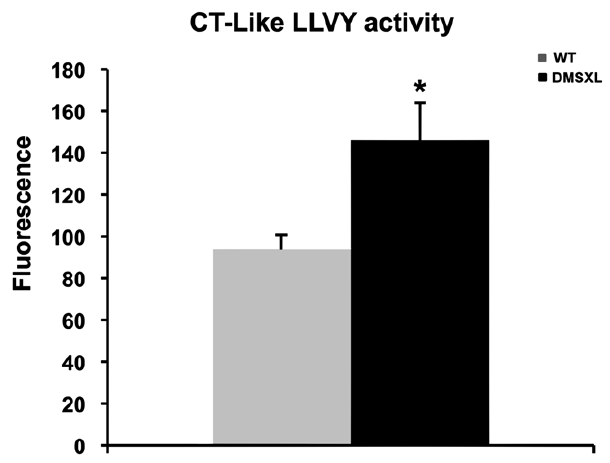
Figure 10. Proteasome activity in DMSXL mice. Chymotrypsin-like activities of the proteasome were assayed using the fluorogenic peptides LLVY-AMC in 4-month-old female WT and DMSXL mice. Each group contained ten animals and each animal was assayed in triplicate. Histogram bars represent the average activity 6 SD for each group (* p , 0.05, Student’s t test).